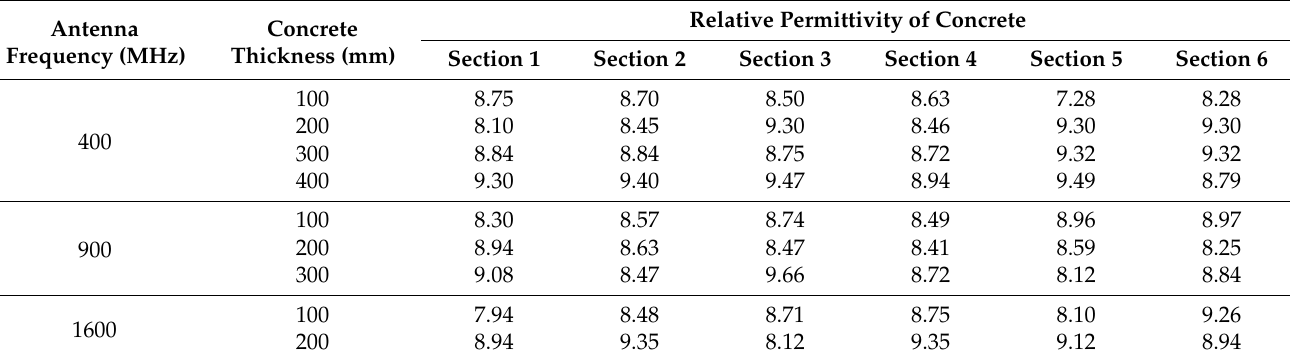
Table 2. Relative permittivity of concrete in the tunnel model